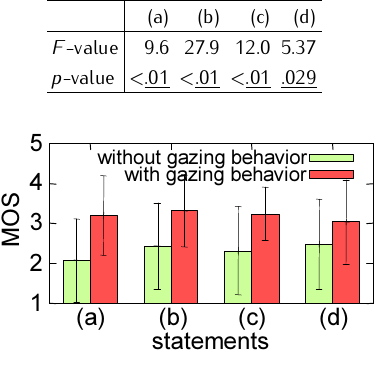
Figure 17. Evaluations for Gaze-correspoinding